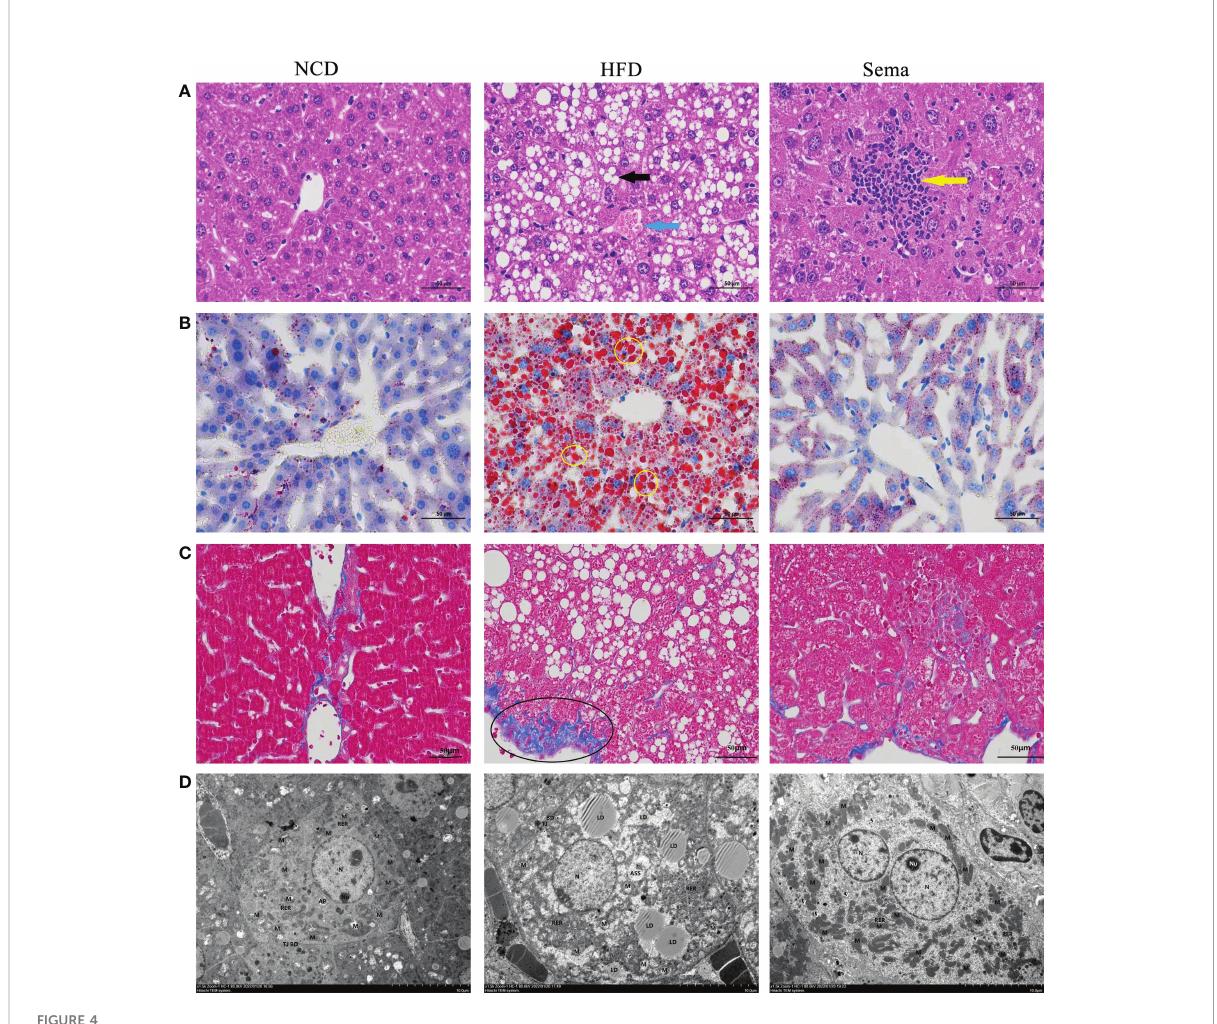
FIGURE 4 Effects of semaglutide on liver histology changes in NAFLD model. (A) Representative images of liver tissues stained with HE staining; (B) Representative images of lipid deposition stained with Oil Red O; (C) Representative images of liver fi brosis stained with Masson; (D) TEM images showed the mitochondria, mitochondrial microautophagy structure and ribosomes; NAFLD, non-alcoholic fatty liver